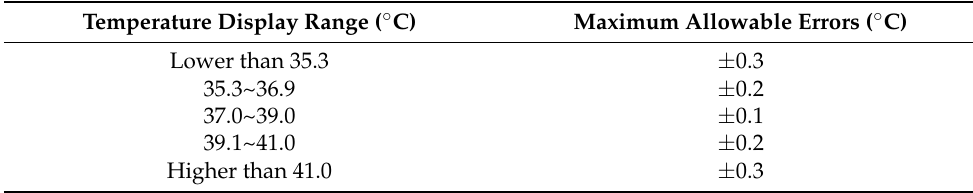
Table 2. Thermometers’ maximum permissible errors by GB/T 21416 in